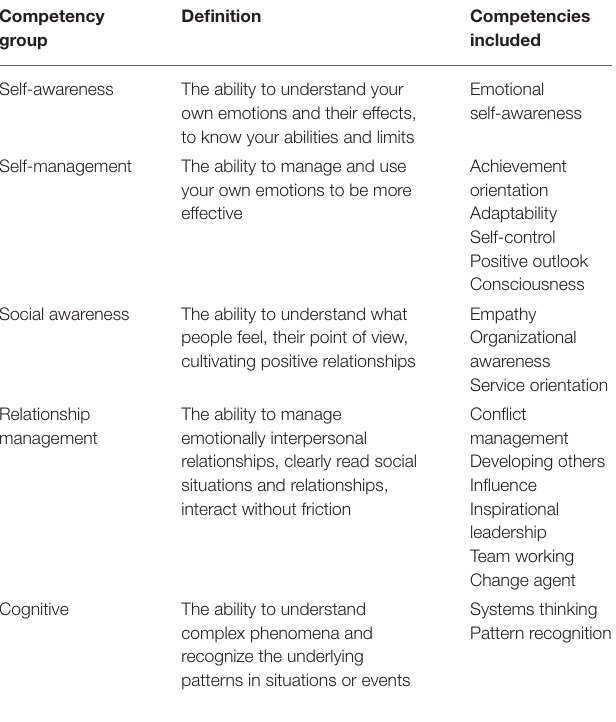
TABLE 1 | Definition of groups and